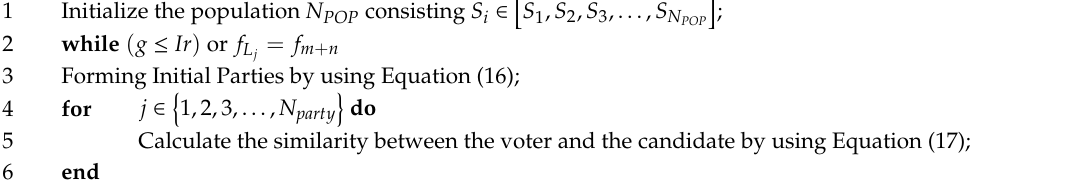
Algorithm 1 Detailed Procedure of the Proposed